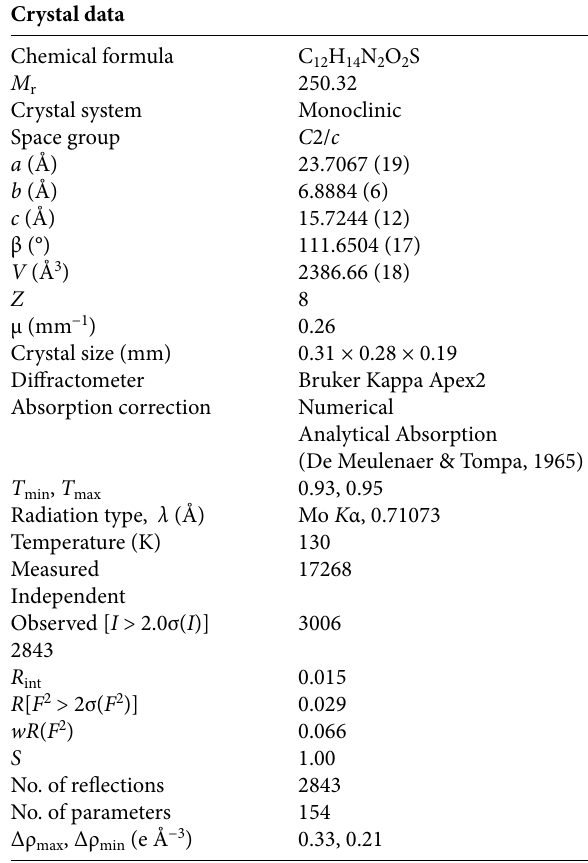
Table 1. Crystallographic and experimental